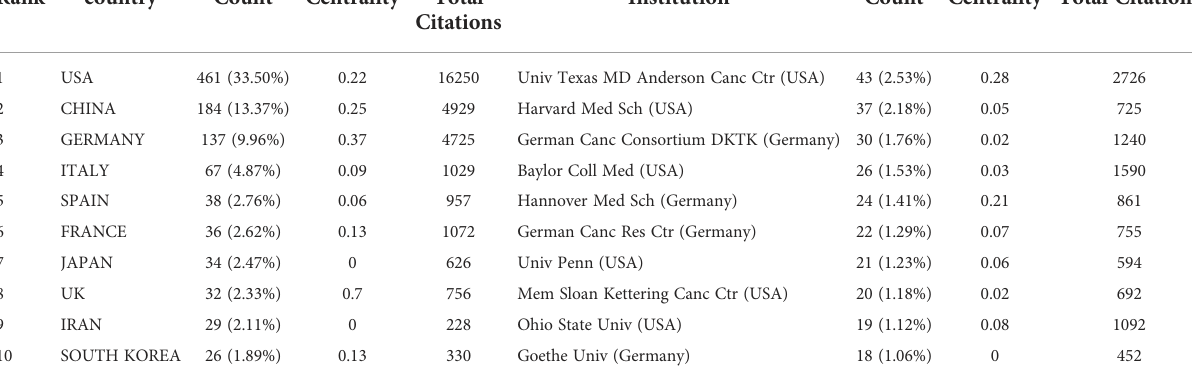
TABLE 1 The top 10 countries and institutions involved in CAR-NK cells.